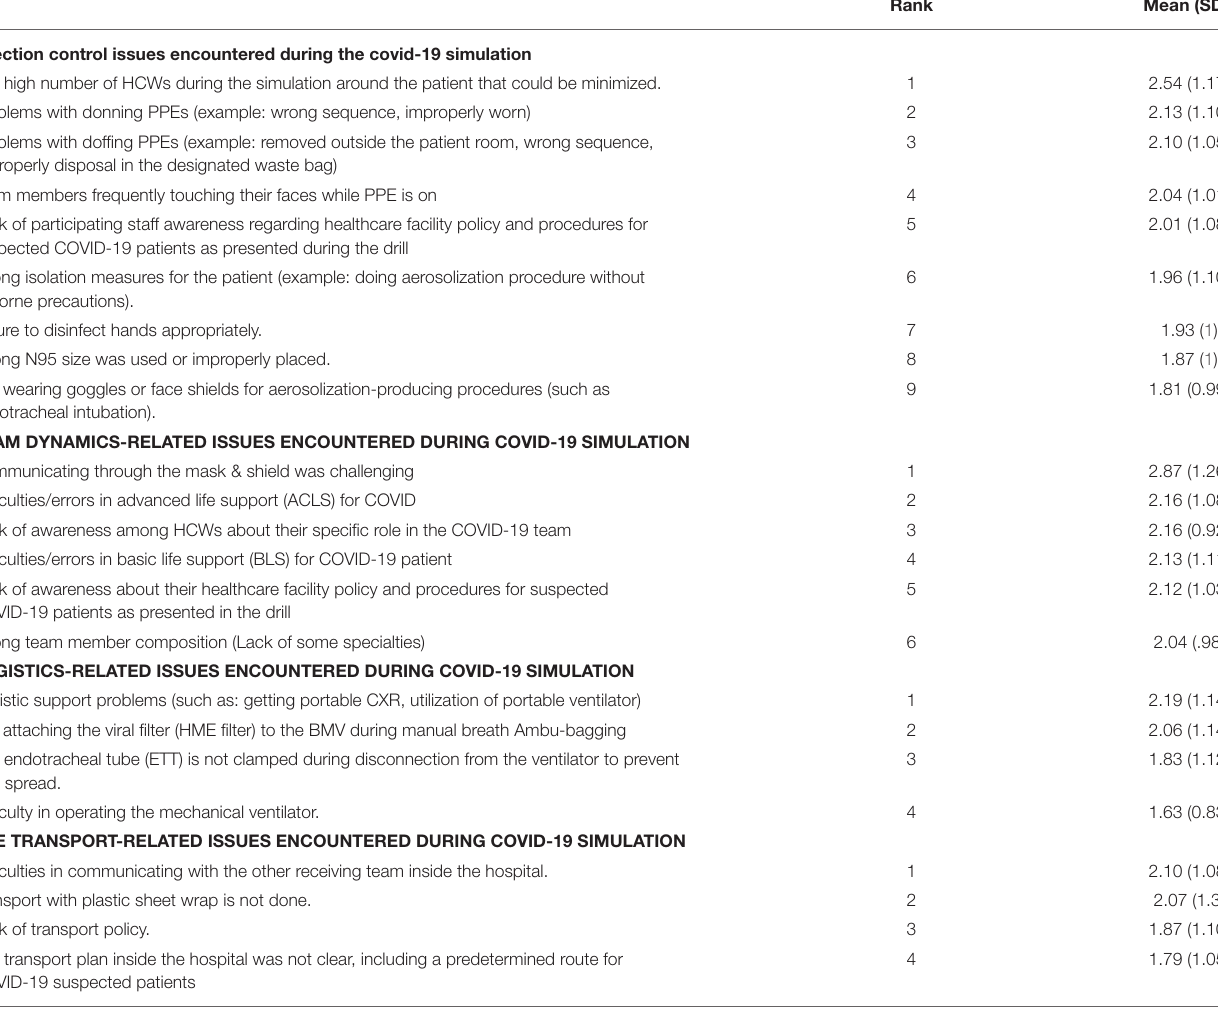
TABLE 4 | Descriptive analysis of issues and problems perceived during COVID-19 simulation.